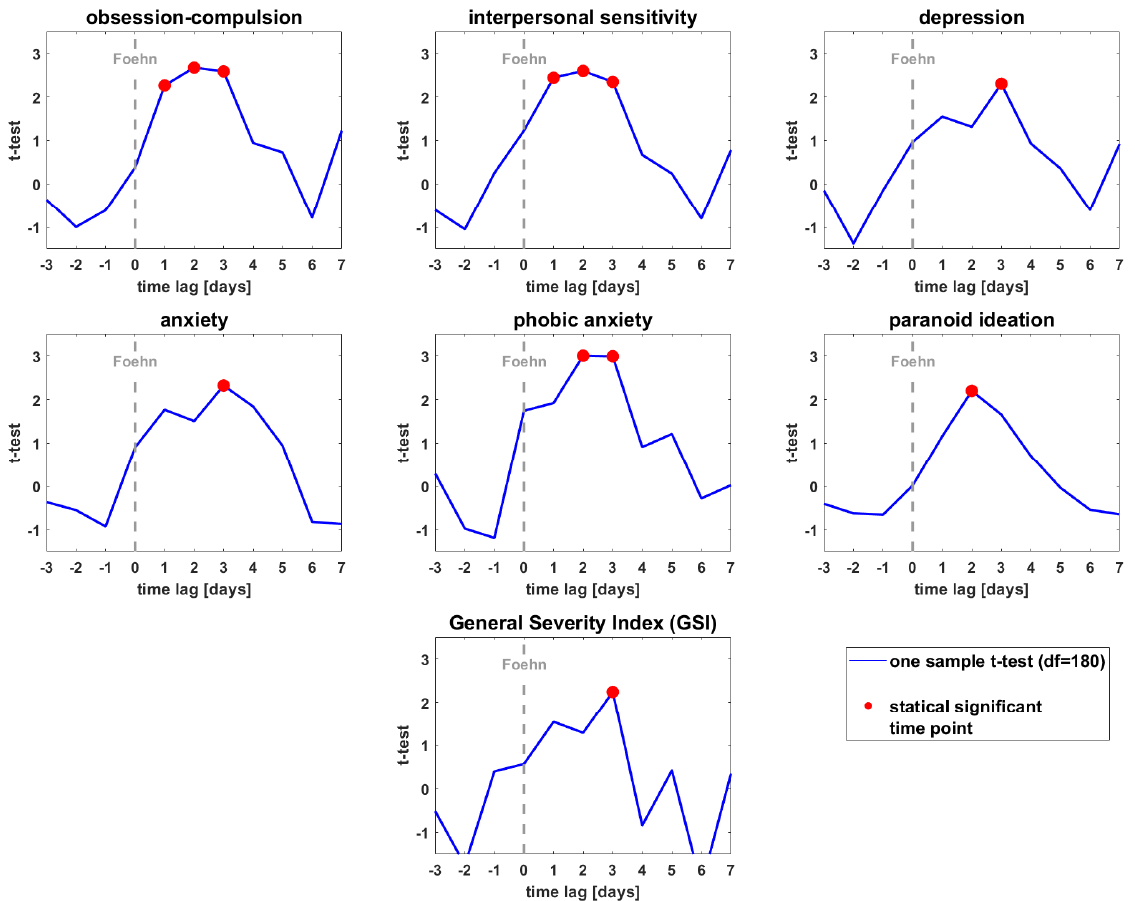
Figure 2. Depicts the t-values of the different significant BSCL variables (at admission) as a function of the time lags. Red dots indicate the significant time lags ( t -test vs. zero p < 0.05).